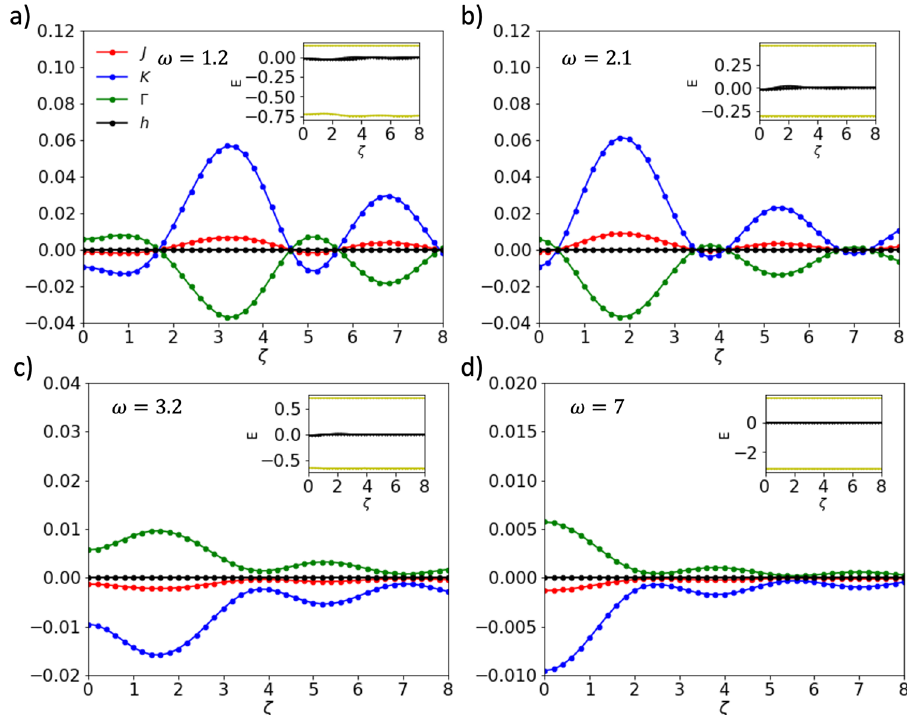
Fig. 2 Tuning spin-exchange couplings ( J , K , Γ ), and emergent magnetic fi eld ( h ) in model without ligands. Panels a – d show J , K , Γ , h as a function of drive strength ( ζ ) for drive frequency ω = 1.2, 2.1, 3.2, and 7, respectively. Inset, in each panel, shows the energy levels (E) in the vicinity of m = 0 Floquet sector and singly occupied states. The black curve (inset) indicates the states with the largest weights on the singly occupied con fi gurations. Note that the vertical axis is plotted in different intervals to highlight the relative strength between different parameters.